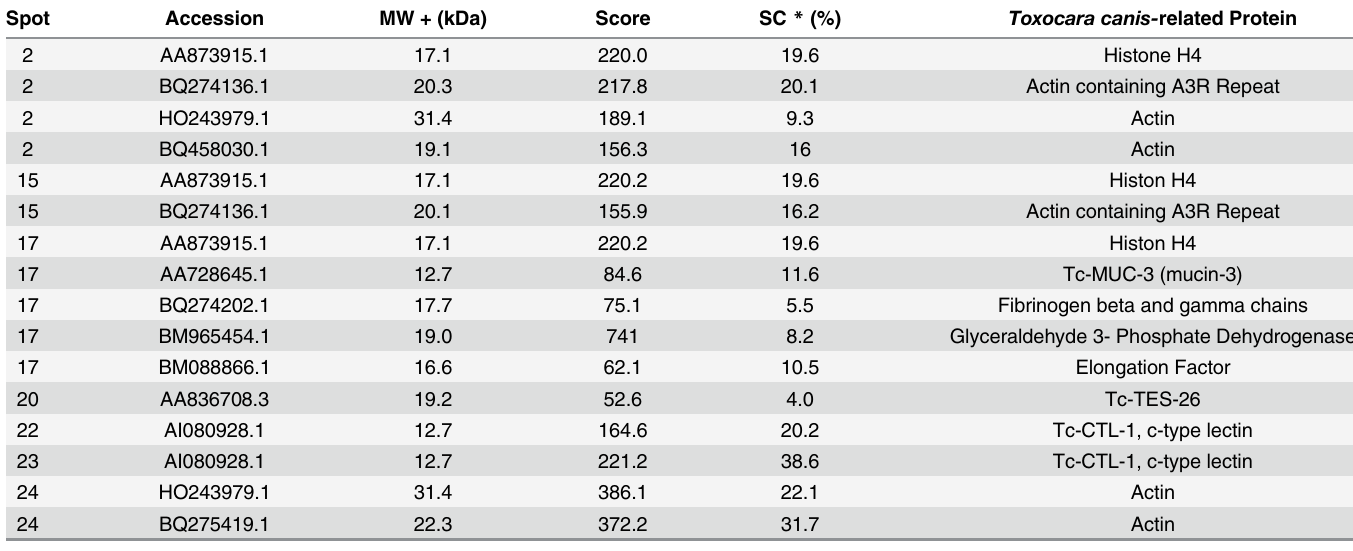
Table 2. Identified mRNA sequences from a T . canis expressed sequenced tag